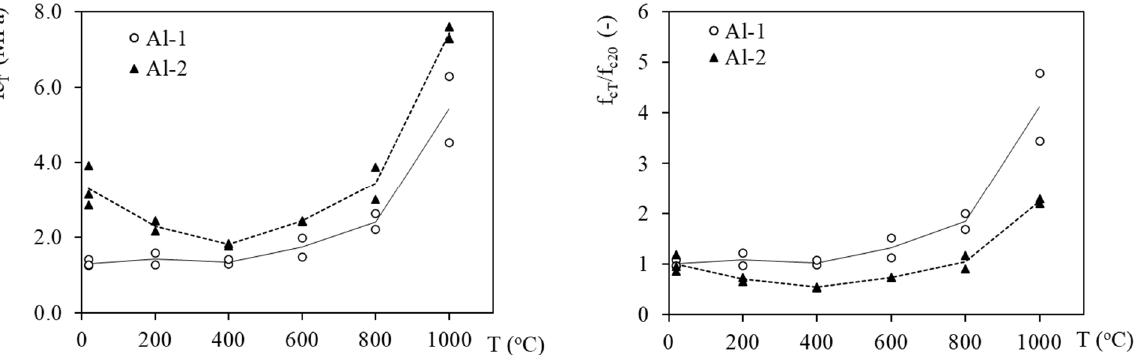
Figure 7. Compressive strength of heated geopolymer foams: absolute values in MPa and relative f cT /f c20 values (-). f cT /f c20 values